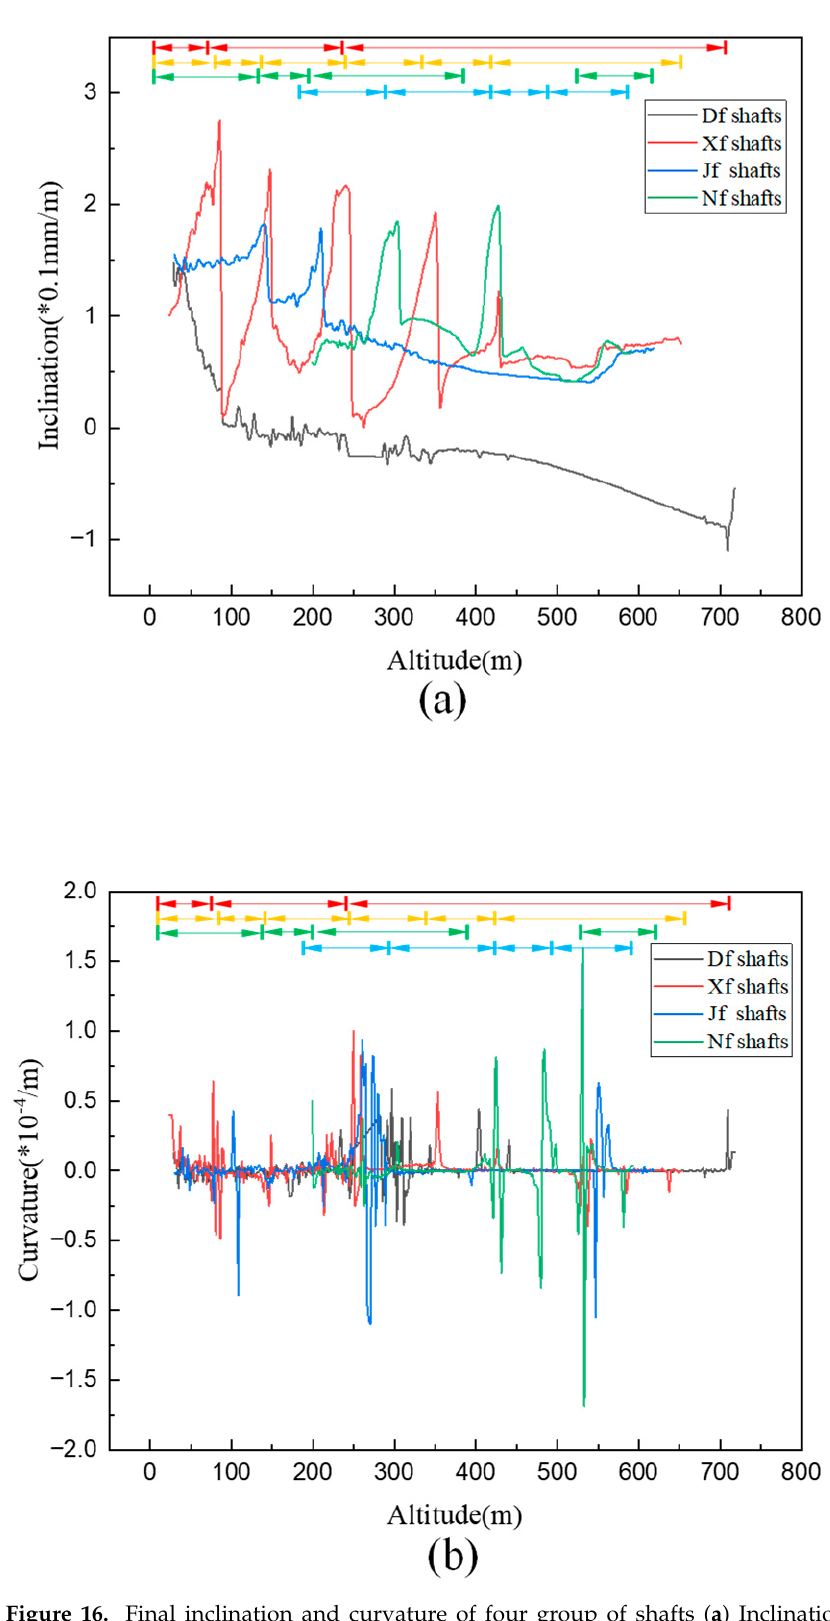
Figure 16. Final inclination and curvature of four group of shafts ( a ) Inclination of the shafts; ( b ) Curvature of the shafts.